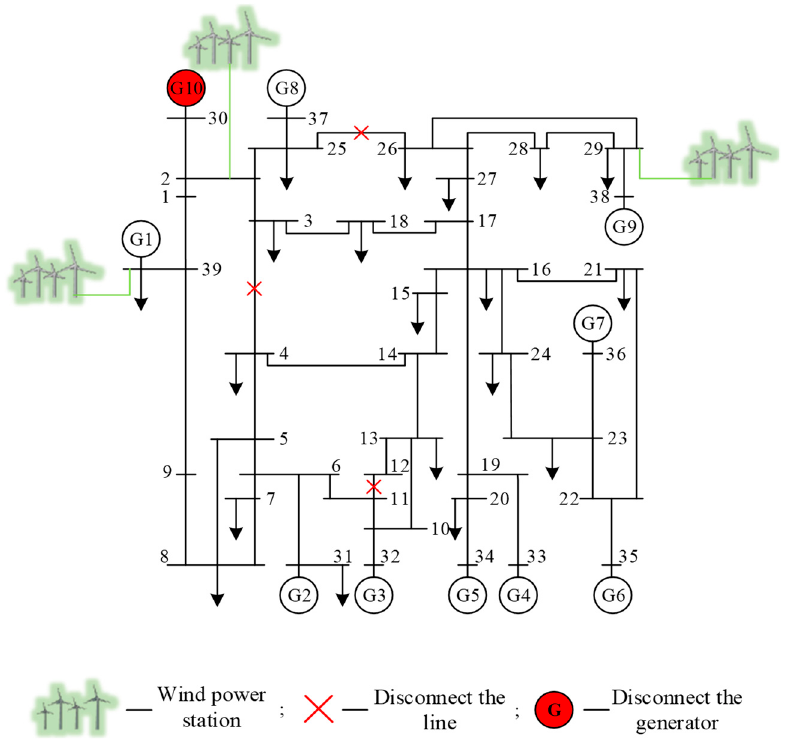
Figure 8. Topology of scenario 3 of the modified New England 39-bus system.